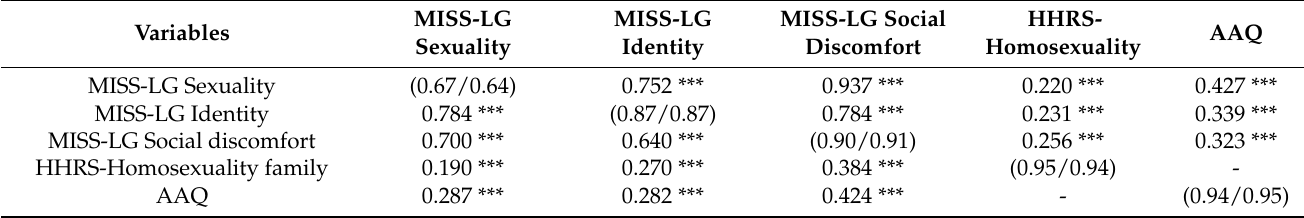
Table 4. Concurrent validity results for the Measure of Internalized Sexual Stigma for Lesbians and Gay Men (MISS-LG).